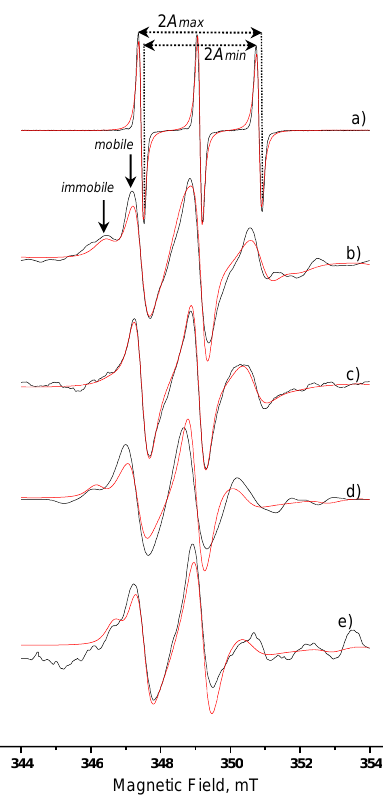
Figure6. EPRspectraof( a )freespin-labeliodoacetamido-TEMPOinaqueoussolution; andspin-labelled C. rugosa lipase in: ( b ) aqueous solution; ( c ) AOT microemulsion w o = 15; ( d ) System A; ( e ) System B. Black line, experimental; red line, simulation. Table 4. τ R , S , and A N values of free iodoacetamido-TEMPO in water and spin-labelled C. rugosa lipase in aqueous solution, AOT microemulsion, and Systems A and